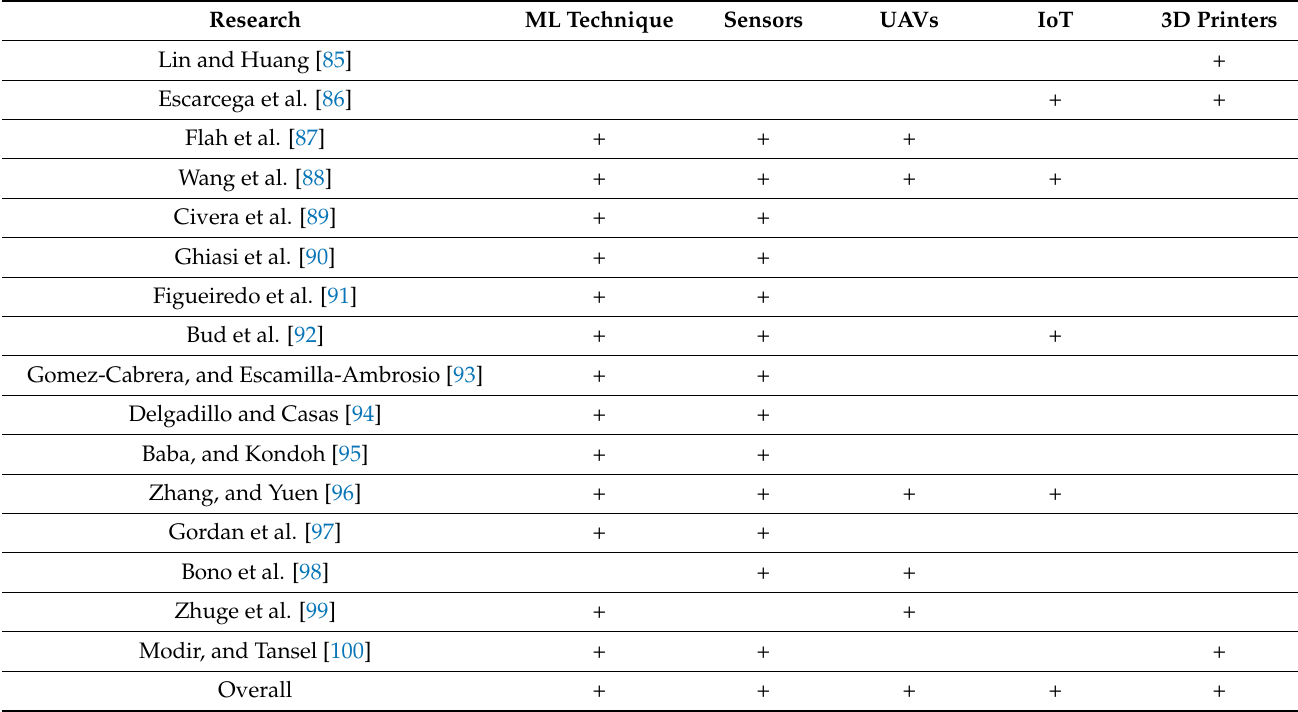
Table 2. Some recent studies on SHM of bridges vs. new